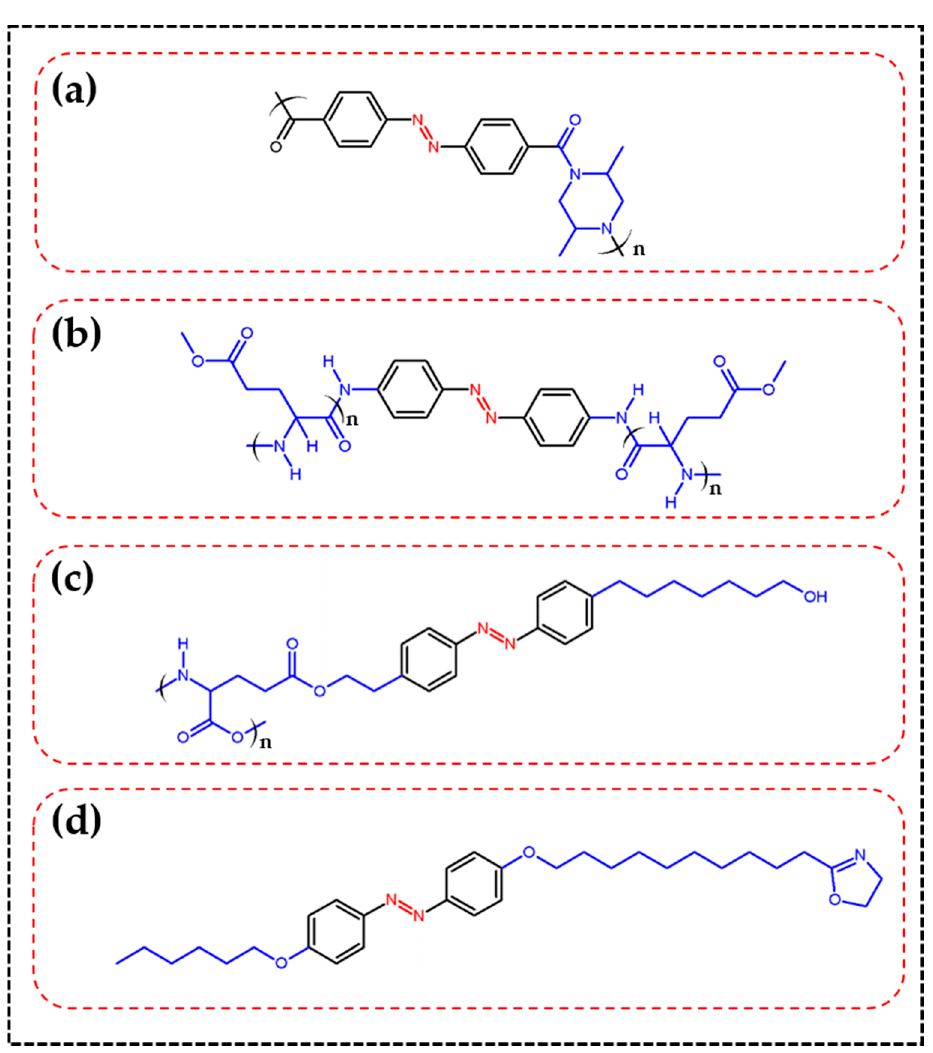
Figure 2. The photomechanical effects caused by trans–cis photoisomerization in some selected polymer systems developed by ( a ) Blair et al. [23], ( b ) Higuchi et al. [24], ( c ) Menzel et al. [25], and ( d ) Seki et al. [26].